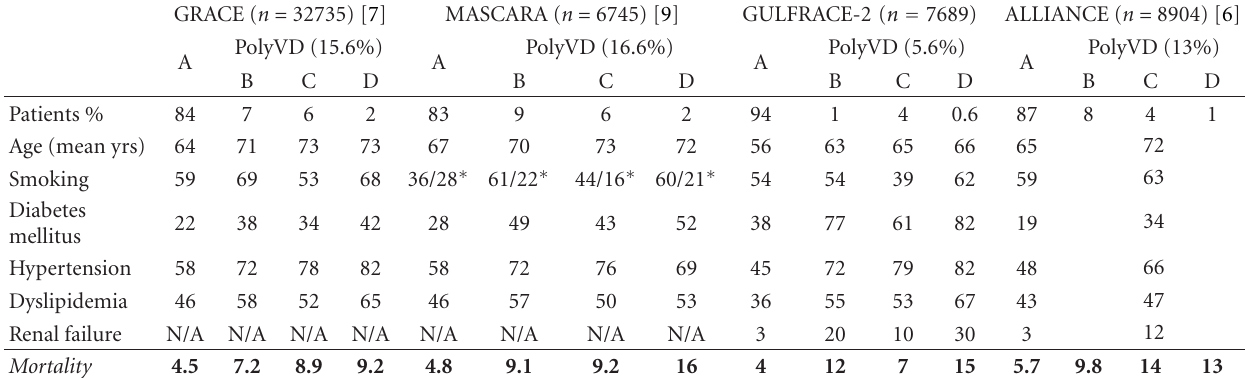
Table 6: Risk factors and in-hospital mortality in patients with versus without polyvascular disease presenting with acute coronary syndrome in di ff erent clinical